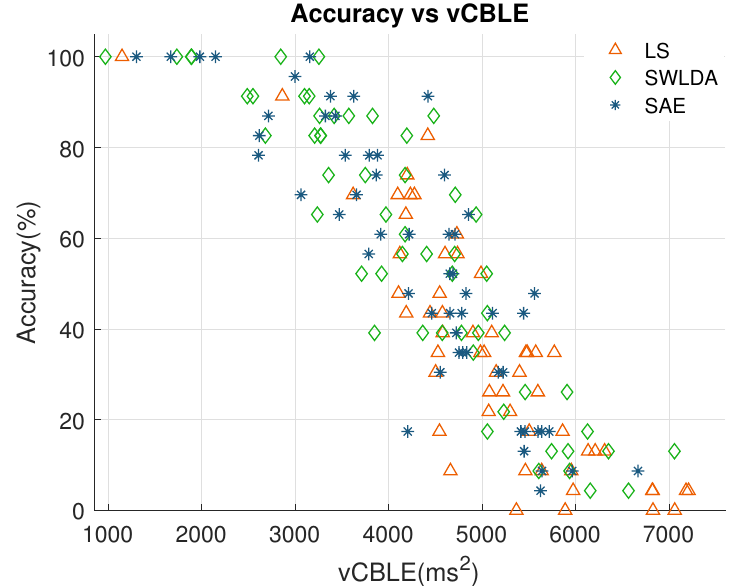
Figure 3. Accuracy plotted against the variance of classifier-based latency jitter estimates (vCBLE) using LS, SWLDA and SAE